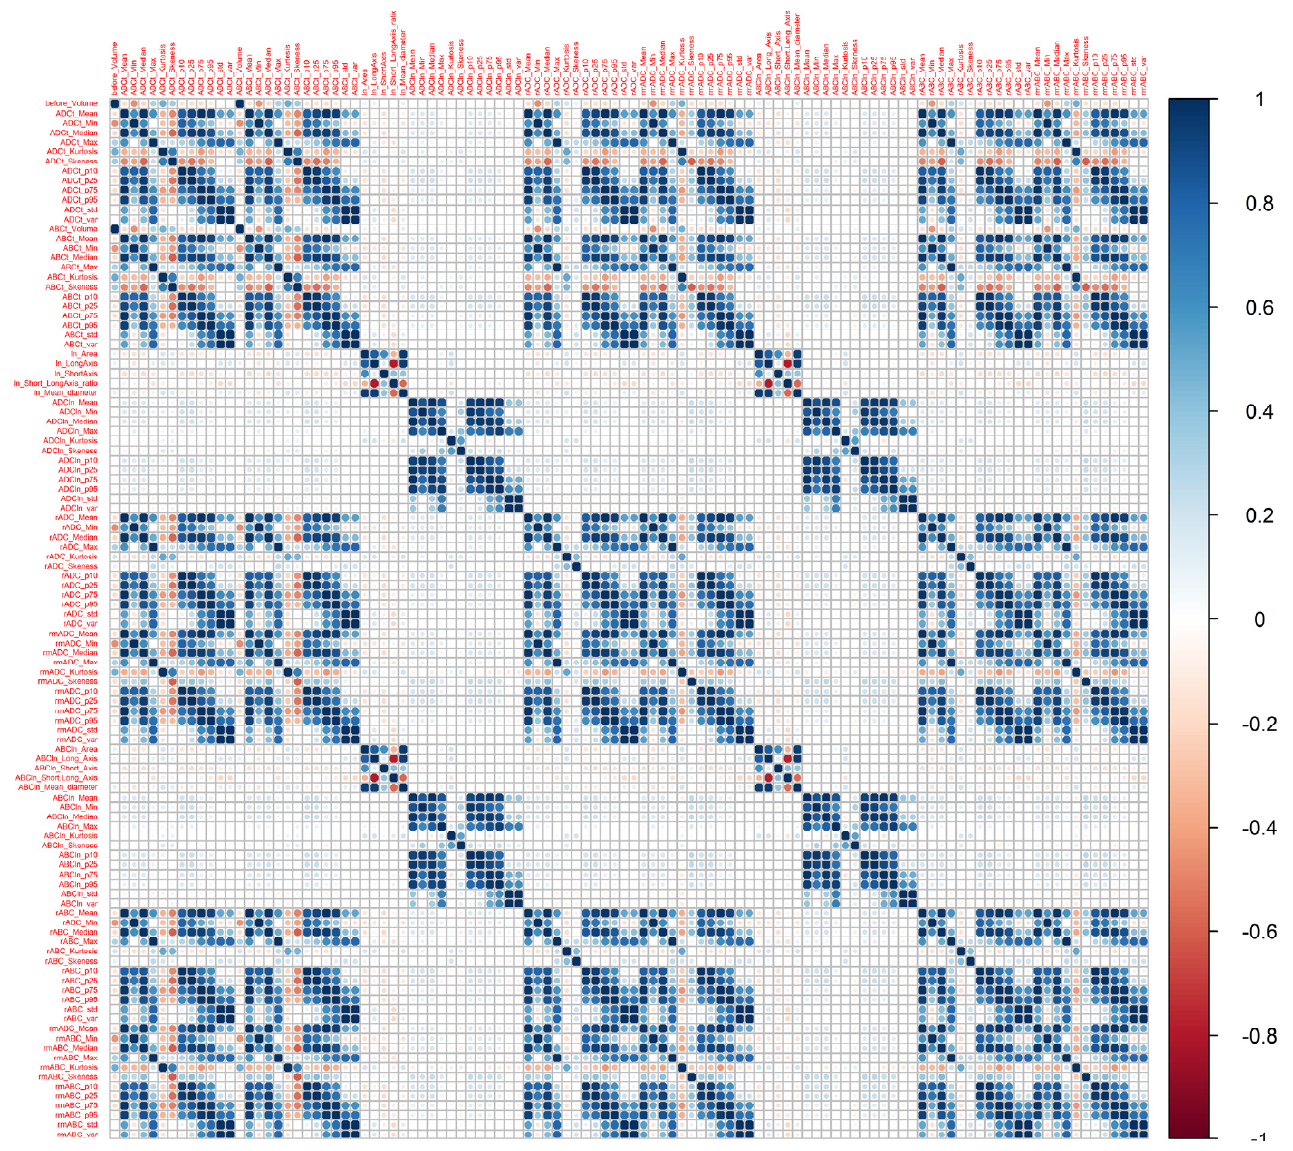
Figure A1. The correlation matrix demonstrated a high correlation among the ADC parameters